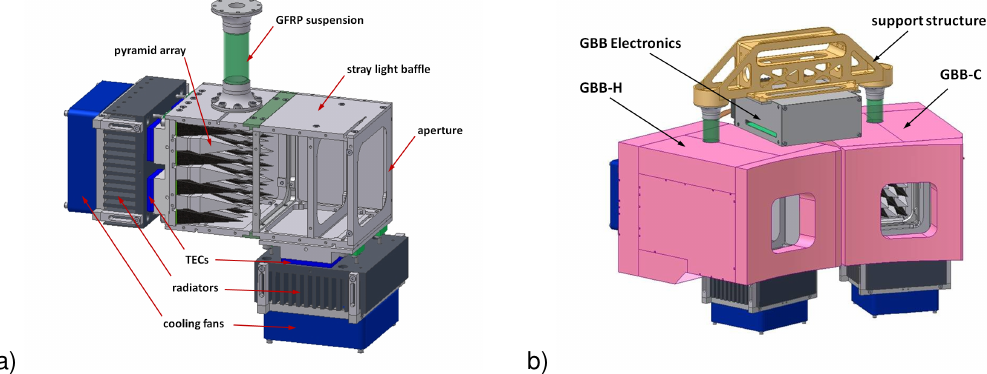
Fig. 3. Design of a GLORIA BlackBody (a) and configuration of the complete GLORIA in-flight blackbody calibration system (b) .